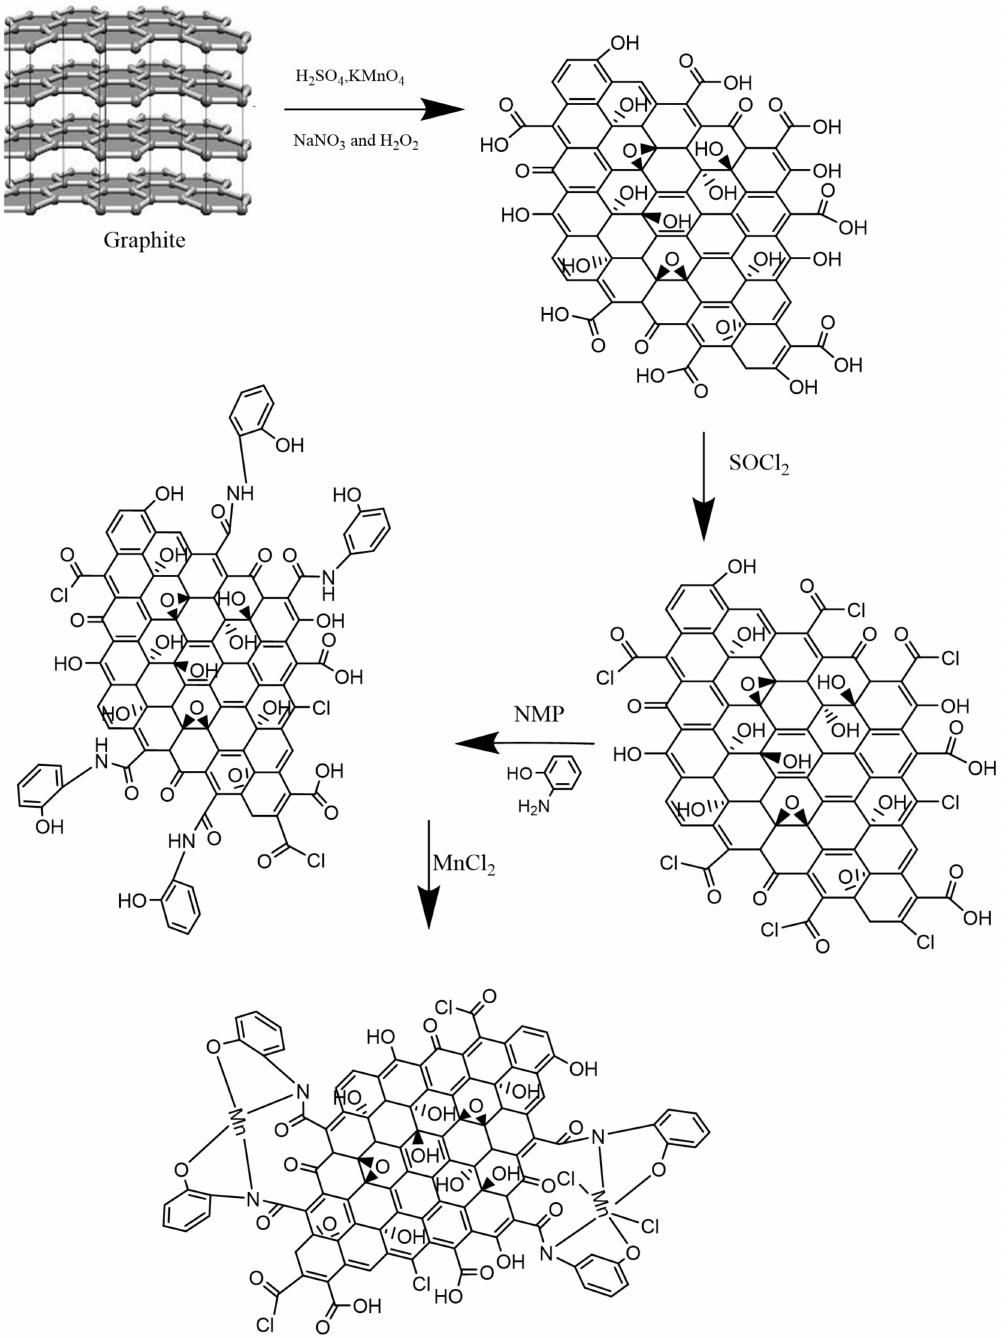
Scheme 1. The preparation procedure of manganese functionalized graphene oxide